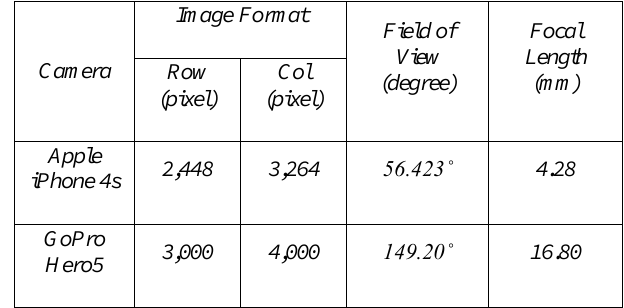
Table 1. Digital cameras used for data set preparation.